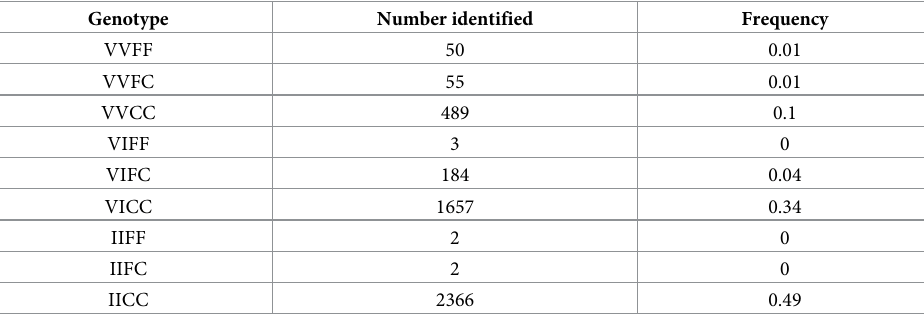
Table 4. Combined genotype frequencies for 1016 and 1534 alleles in 4,810 Florida Ae . aegypti